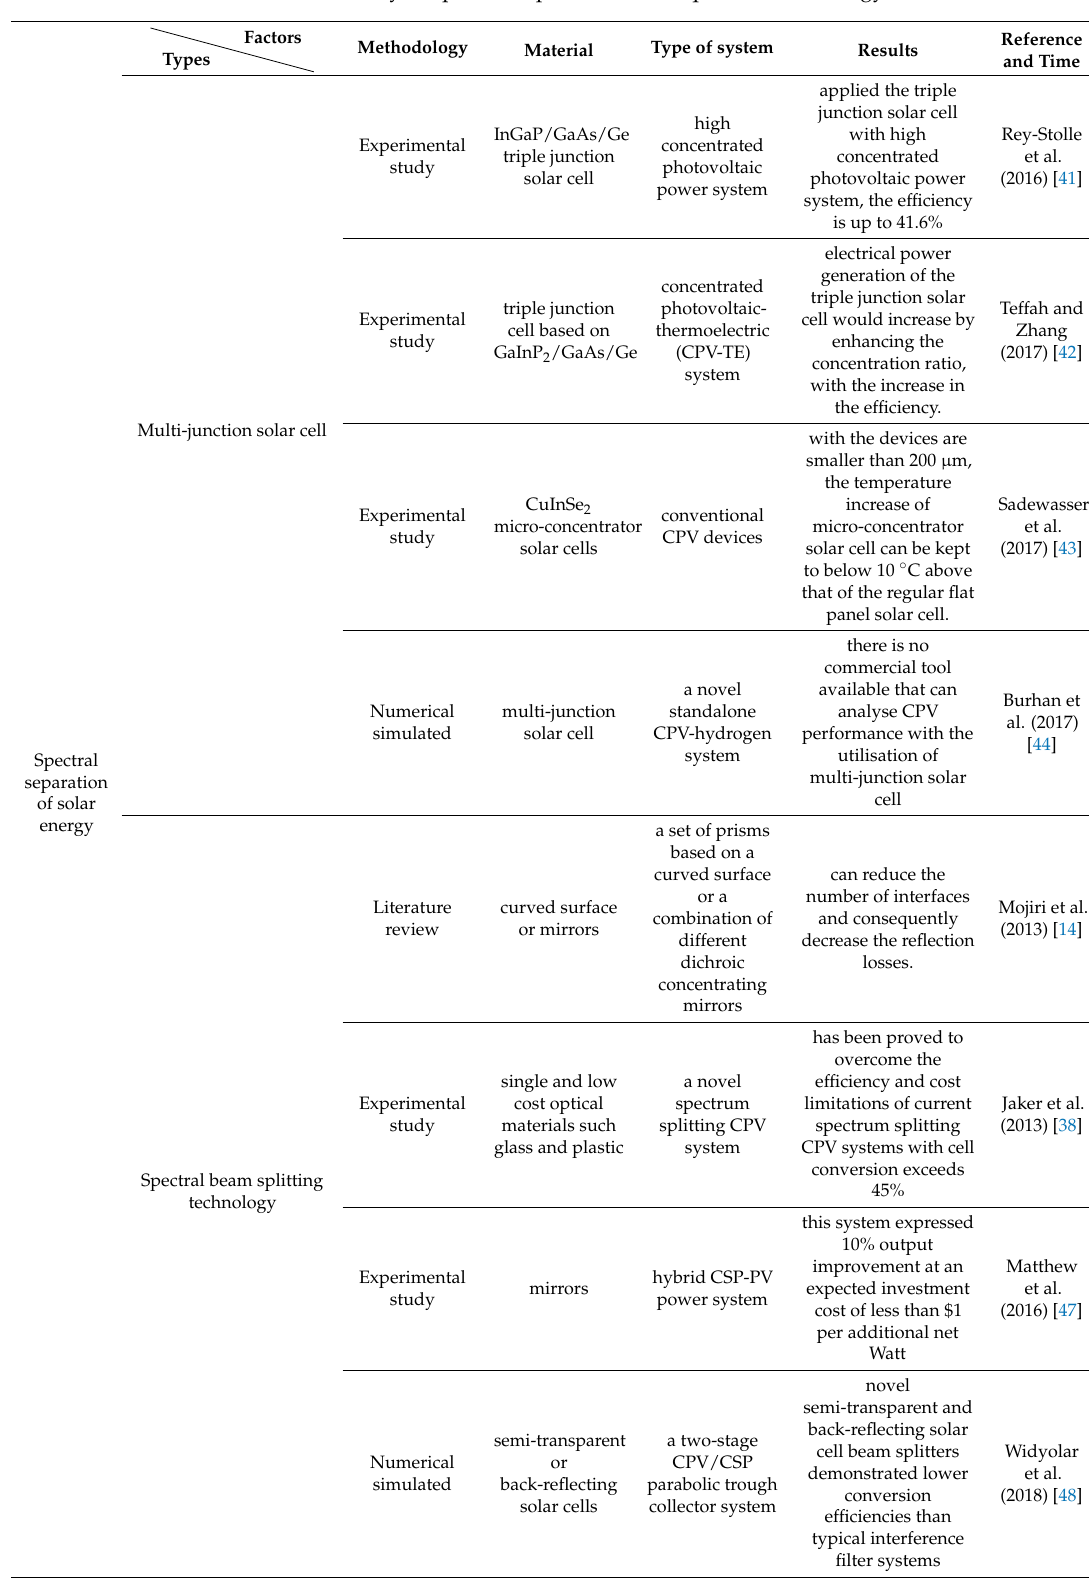
Table 1. Summary of spectral separation techniques of solar